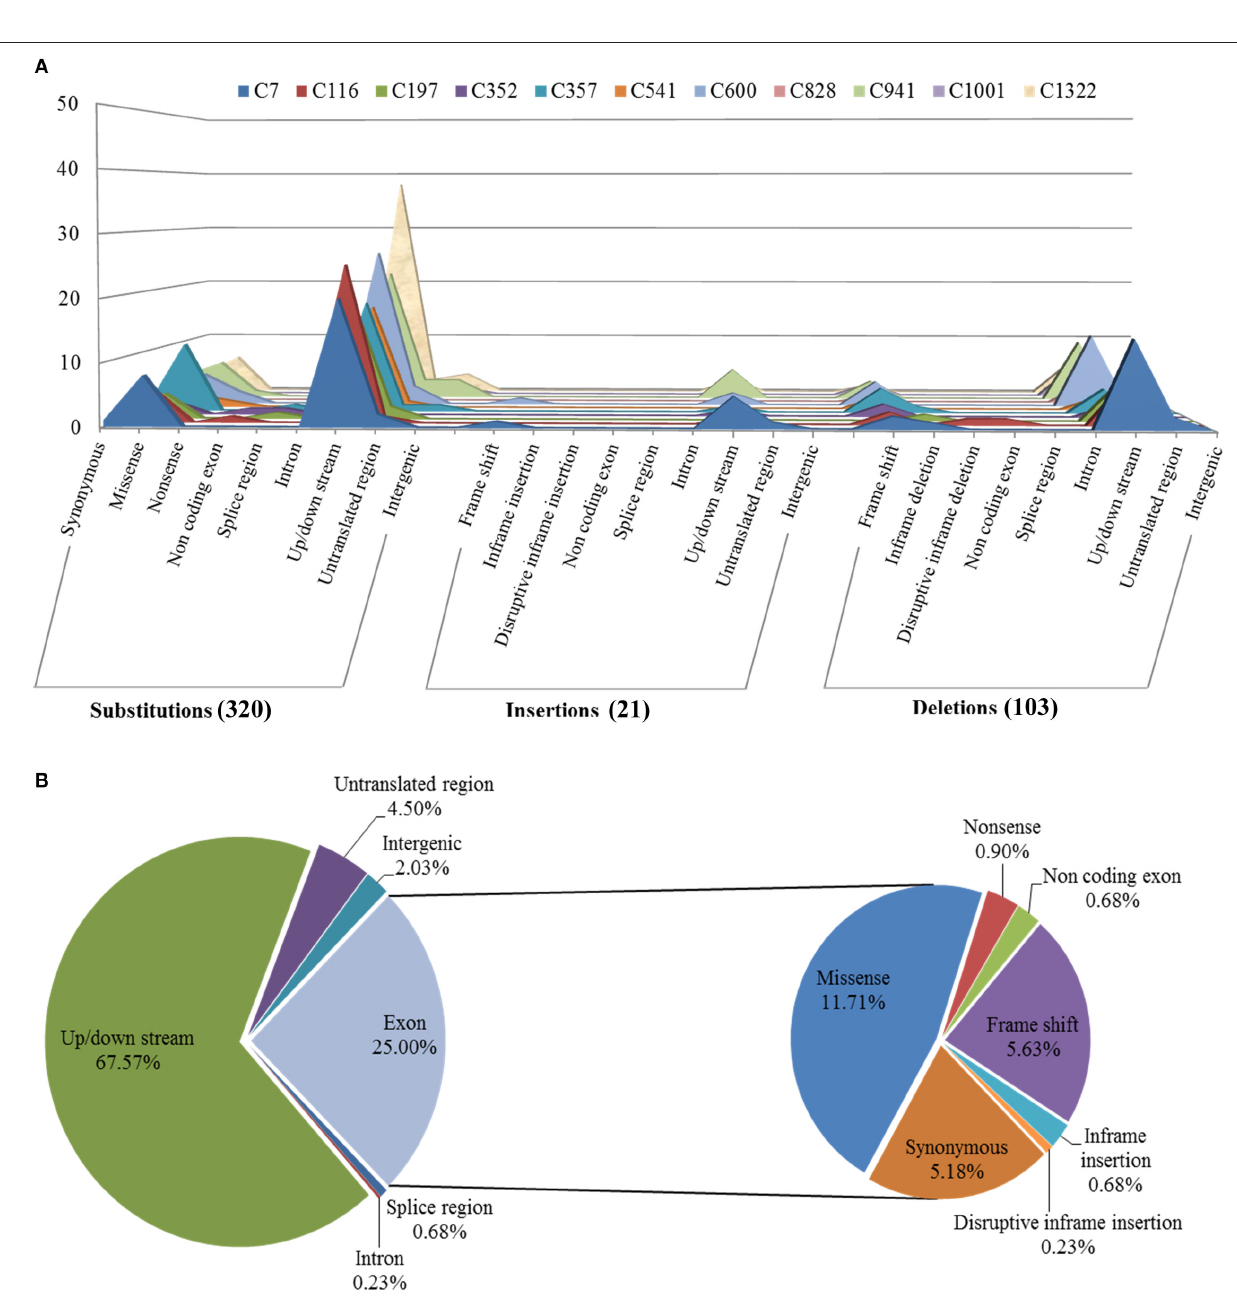
Frontiers in Plant Science |